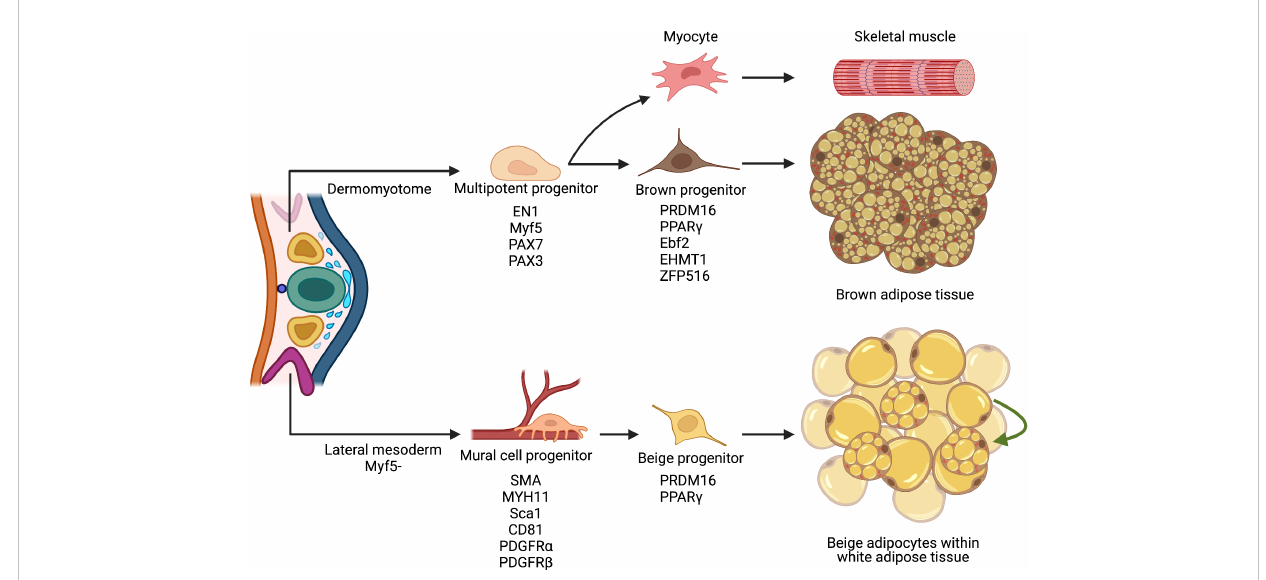
FIGURE 2 Cellular ontology of thermogenic fat biogenesis. Multipotent progenitor cells located within the paraxial mesoderm of the dermomyotome can give rise to brown fat precursors that express myogenic markers. Though brown fat and skeletal muscle may share similar cellular ancestry, speci fi c transcriptional factors regulate and facilitate brown adipocyte lineage speci fi cation and determination. Contrastingly, white and beige adipocytes arise from a Myf5- mesodermal origin, resemble mural cells, and reside in a perivascular niche. Upon cold exposure, these cells invoke a thermogenic transcriptional program and differentiate into beige adipocytes. Illustration created with